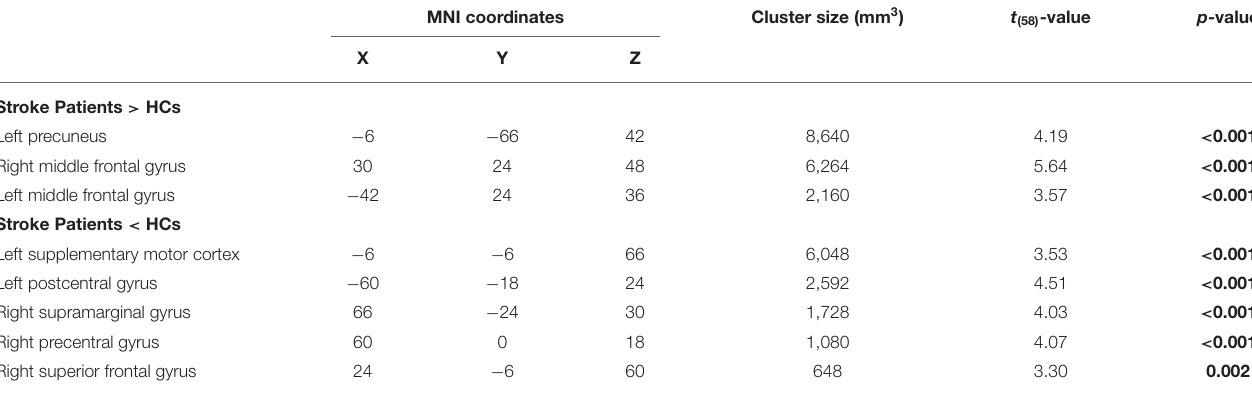
TABLE 4 | Brain regions with significant differences in R LOC functional connectivity between right-sided stroke patients and